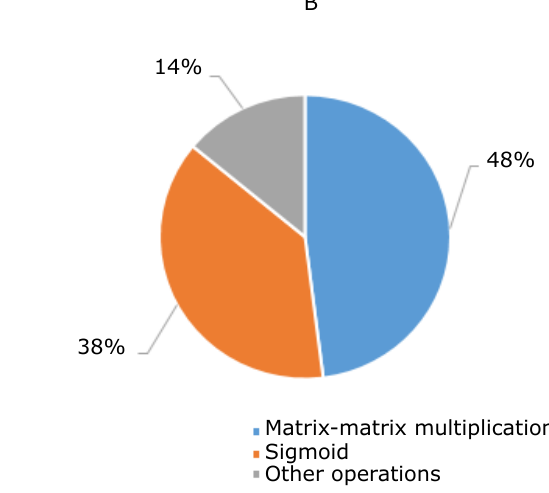
Figure 2. Code profiling. ( A ) shows the profiling of the autoencoder while ( B ) shows the profiling of the training